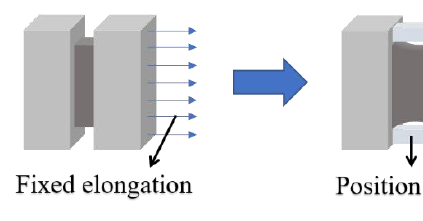
Figure 3. Fixed elongation test process.